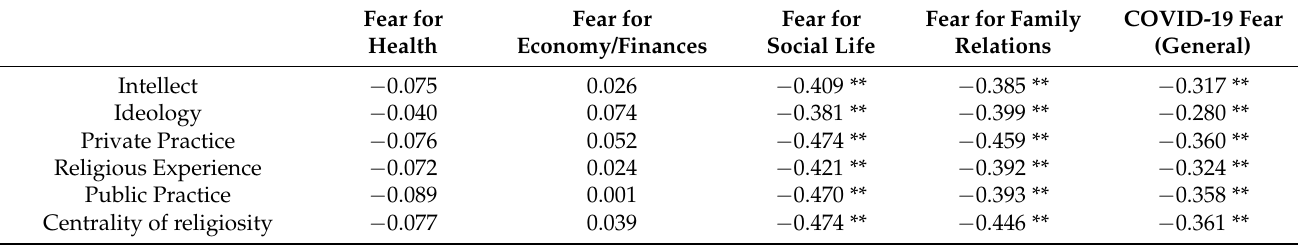
Table 3. Correlates of increased COVID-19 fears during the pandemic as measured by responses expressing level of fear from 1 to 10.